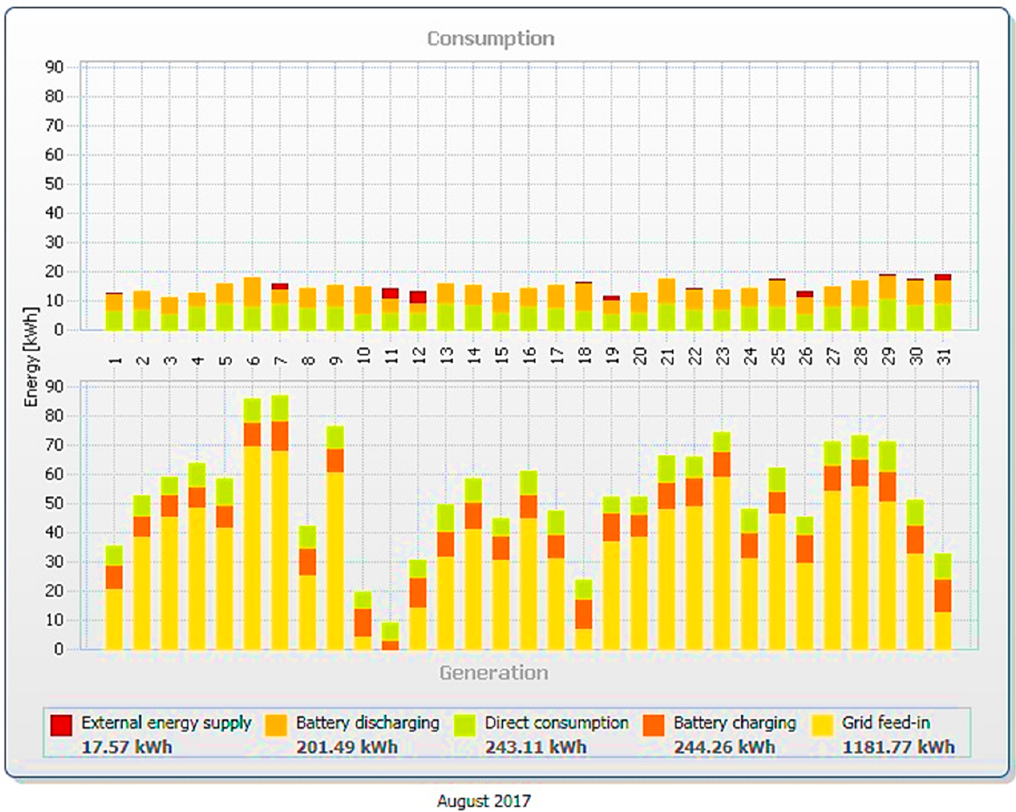
Figure 6. Illustrating the main logic of calculations with energy balance data from an actual flexible storage PV system [84]. System informations: PV system power: 14.760 kW; Nominal battery capacity: 9800 Wh; Battery type: Lithium-Ion; Location: Kassel, Germany.